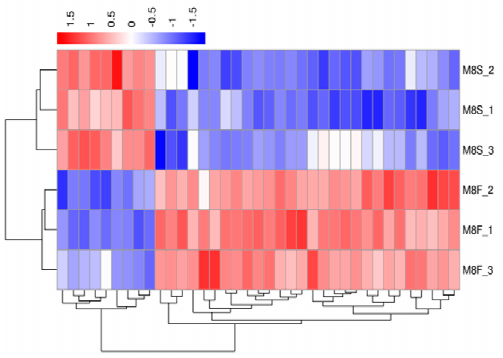
Genes 2019 , 10 , x FOR PEER REVIEW Figure 4. Overall FPKM hierarchical clustering map of the four-week-old females.